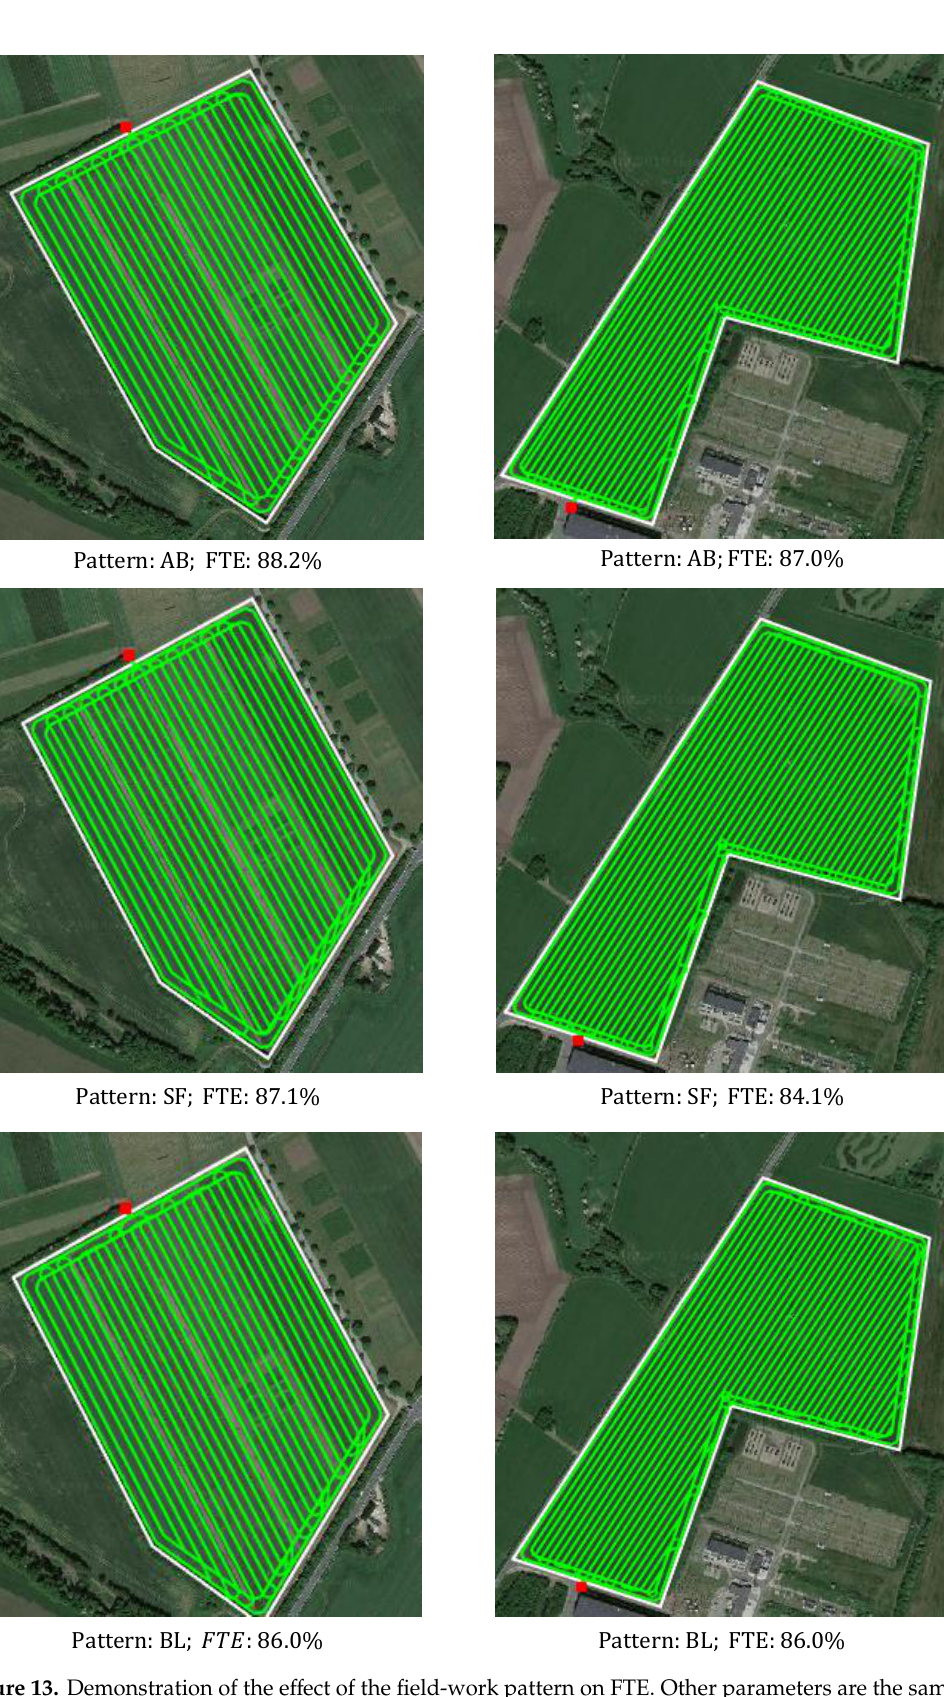
𝐹 = AB; 𝑤 = 9; 𝑟 = 6; ℎ = 2; FTE = 76.1% ( a ) 𝐹 = SF; 𝑤 = 7.5; 𝑟 = 6; ℎ = 2; FTE = 78.2% ( b ) 𝐹 = 𝐴𝐵; 𝑤 = 7.5; 𝑟 = 6; ℎ = 2; 𝐹𝑇𝐸 = 88.3% ( c ) 𝐹 = 𝑆𝐹; 𝑤 = 9; 𝑟 = 6; ℎ = 2; 𝐹𝑇𝐸 = 82.2% ( d )